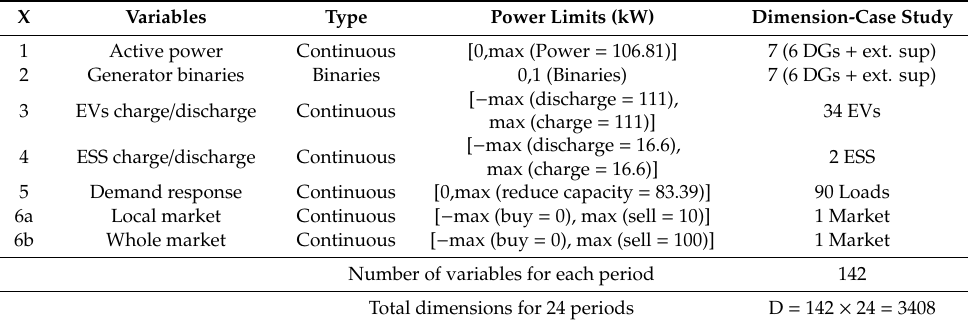
Table 2. Variables representations (from [5,7]).